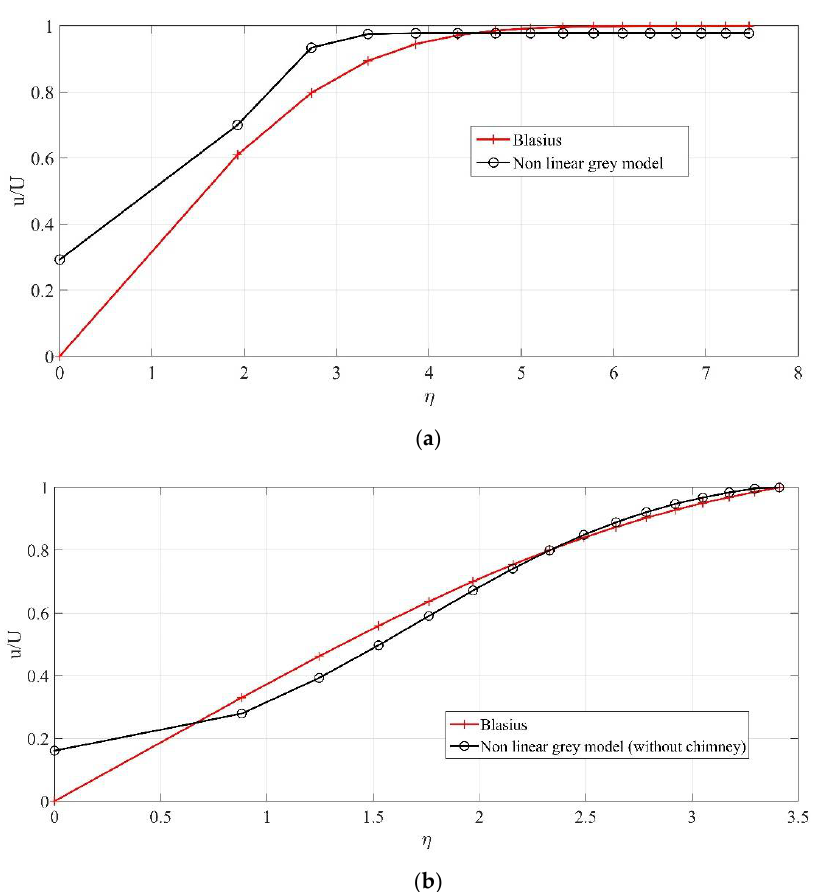
(cid:4673) with stretching factor ( η ): ( a ) chimney, ( b ) without (cid:3022)